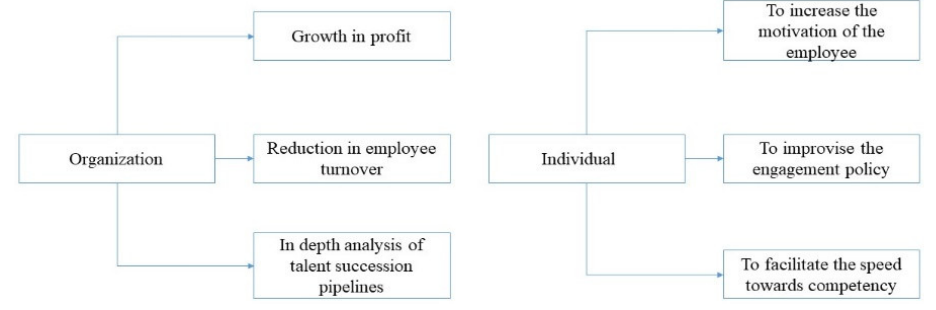
Figure 4. Employee Figure 4. Employee Training.